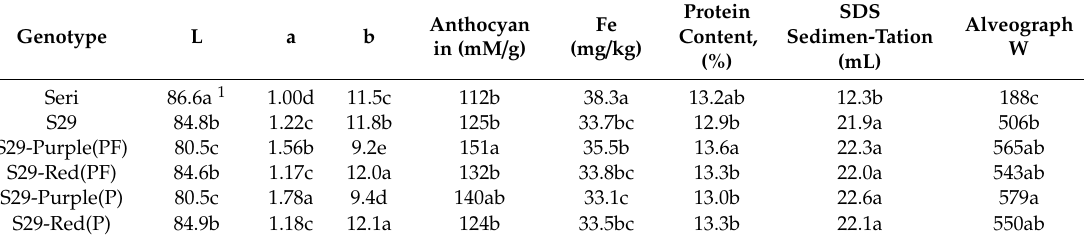
Table 5. Average grain quality traits in purple grain isogenic lines across sites in